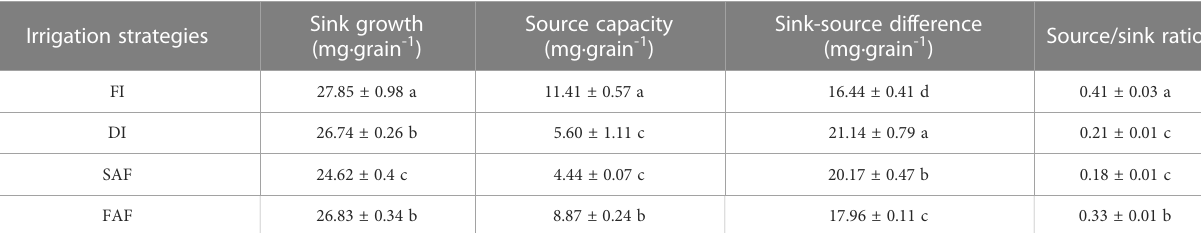
TABLE 4 Sink growth, source capacity and source-sink balance in different irrigation strategies.